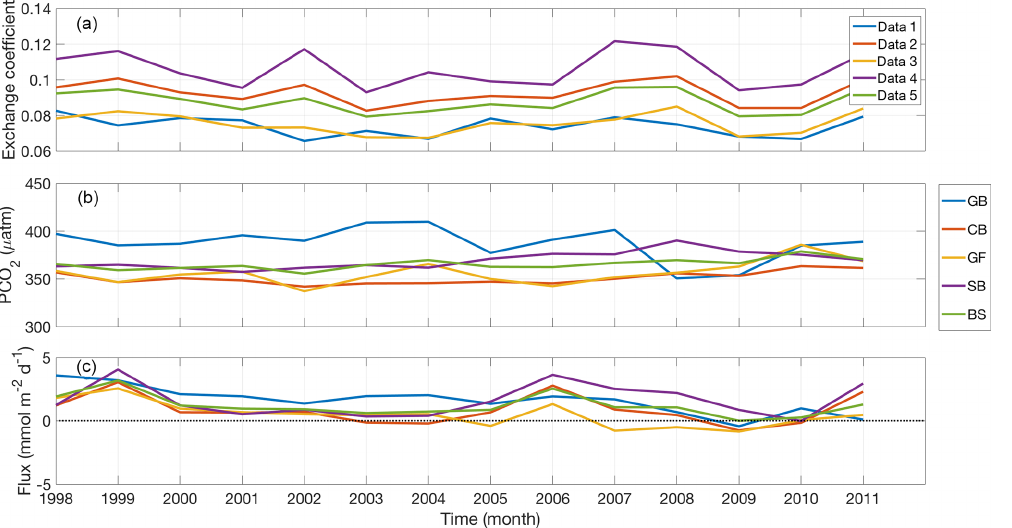
Figure 4. Annual evolution of the (a) transfer velocity based on Wanninkhof et al. (2009). (b) P CO 2 and (c) air–sea CO 2 flux based on the SMHIp wind product for each basin. In the legend: GB: Gulf of Bothnia; CB: Central Basin; GF: Gulf of Finland; SB: South Basin; and BS: Baltic